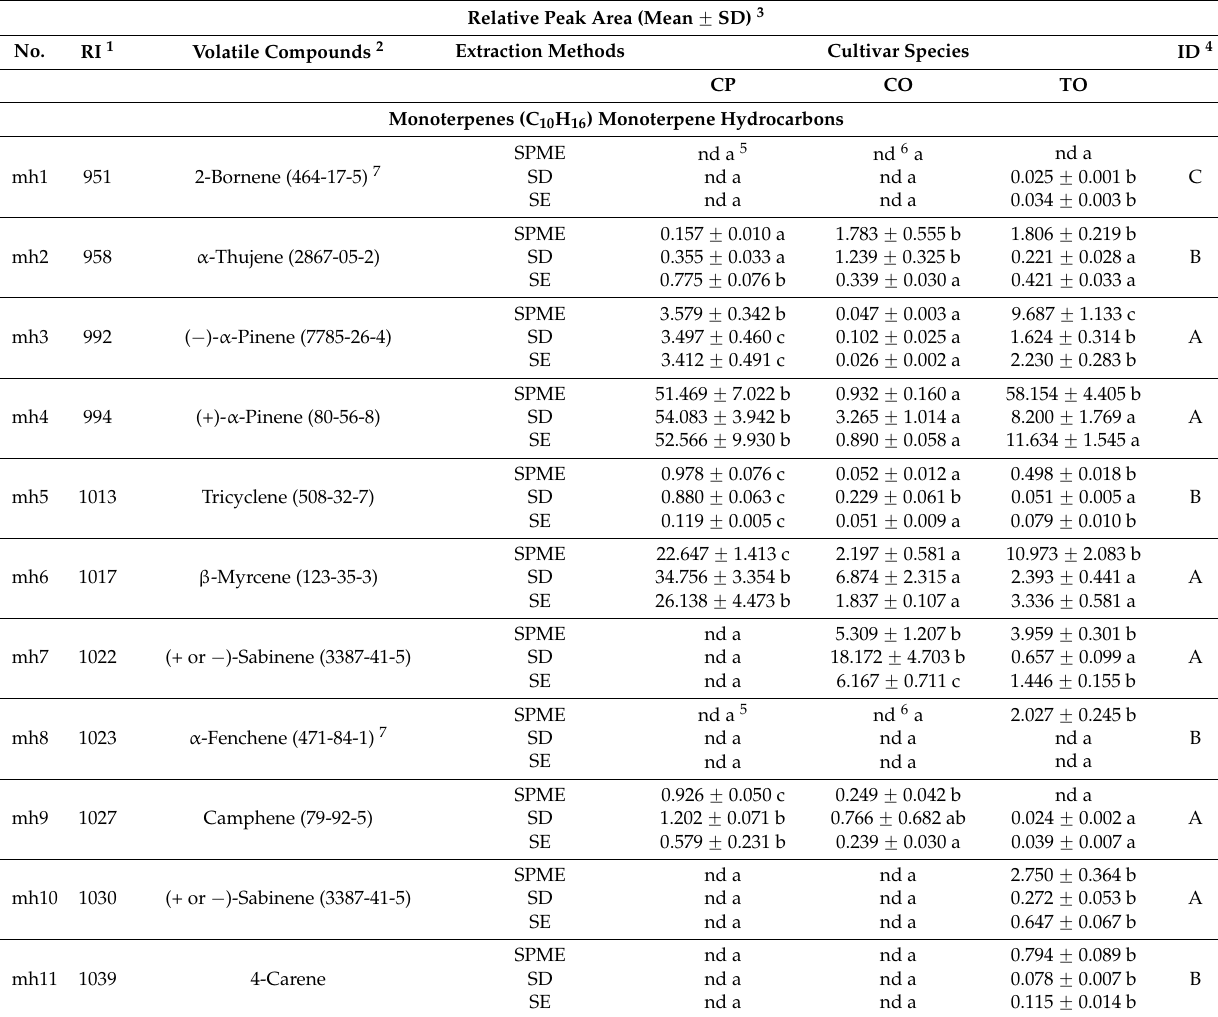
Table 2. Monoterpenes (monoterpene hydrocarbons and oxygenated monoterpenes) of three different cultivars based on different extraction